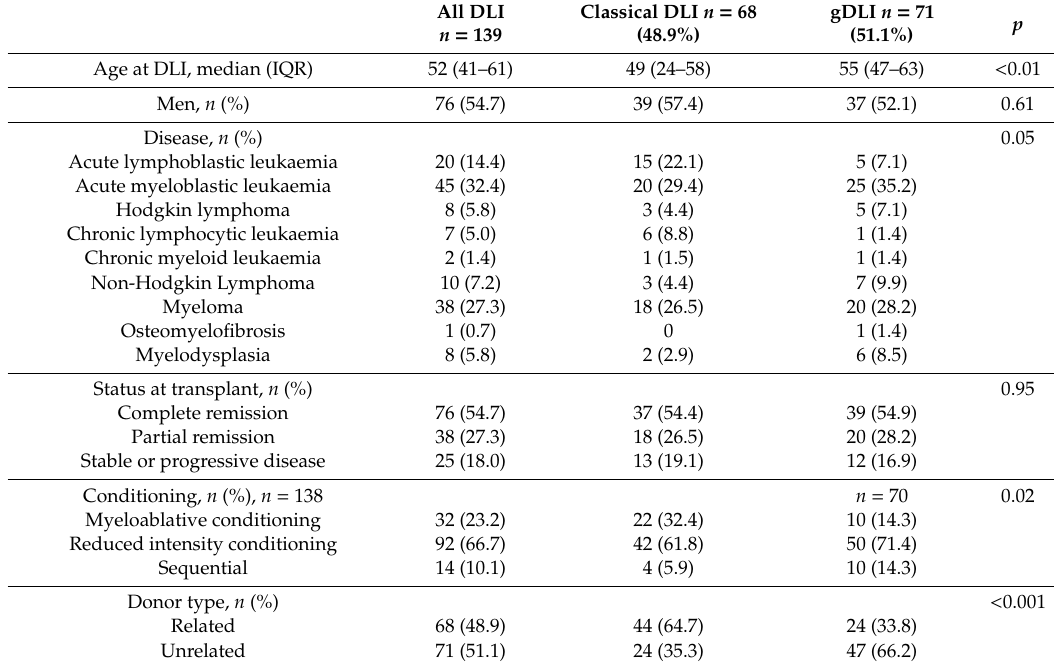
Table 1. Patients characteristics, n = 139.